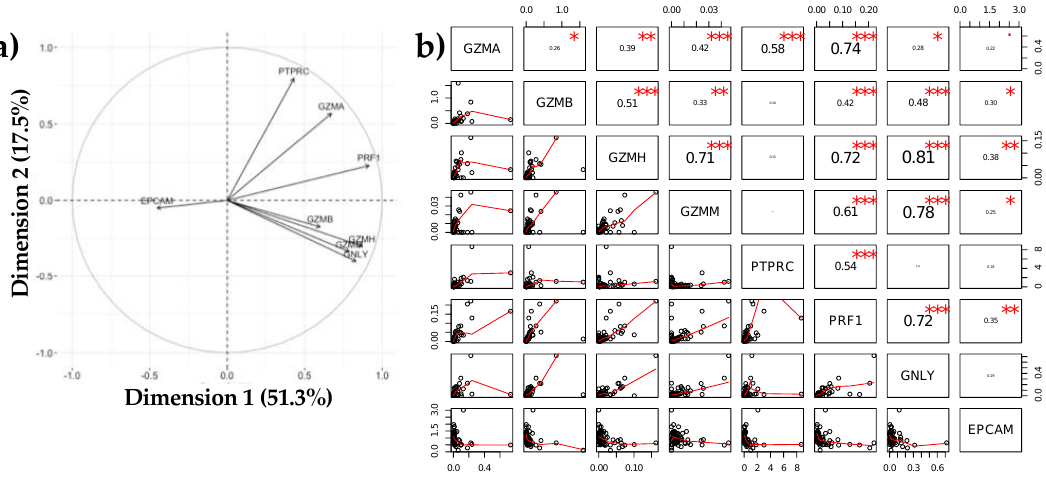
Figure 3. Associations between immune (GZMA, GZMB, GZMH, GZMM, GNLY, PRF1, PTPRC) and epithelial cell markers (EPCAM) analysed with ( a ) principal component analysis (PCA) and ( b ) Linear modelling. Half of the variation could be explained by difference between EPCAM and the immune markers. Moreover, 17.5% was due to the difference between expression of genes encoding granzyme B (GZMB), granzyme H (GZMH), granzyme M (GZMM) and granulysin (GNLY) compared to granzyme A (GZMA), perforin (PRF1) and immune cell marker PTPRC. Linear associations displayed a positive association of gene expression between PRF1 and GZMA, PRF1 and GZMB, PRF1 and PTPRC as well as between GZMA and GZMB. On the other hand a negative association exists between expression of EPCAM and GNLY. *** represents highly correlative genes ( r 2 > 0.5), ** moderately correlative (0.5 > r 2 > 0.3) and * low correlation between genes ( r 2 < 0.3).